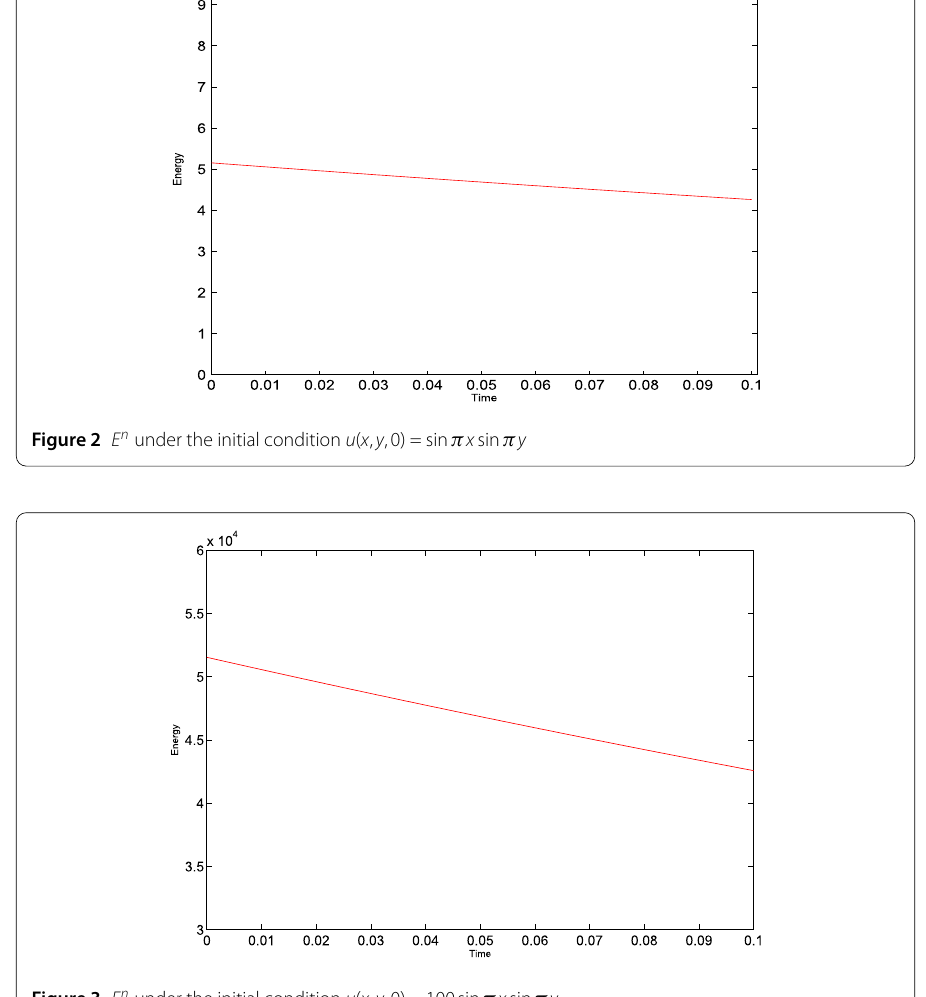
Table 1 Error results of (cid:7) I h u n – U n t (cid:3) t = h